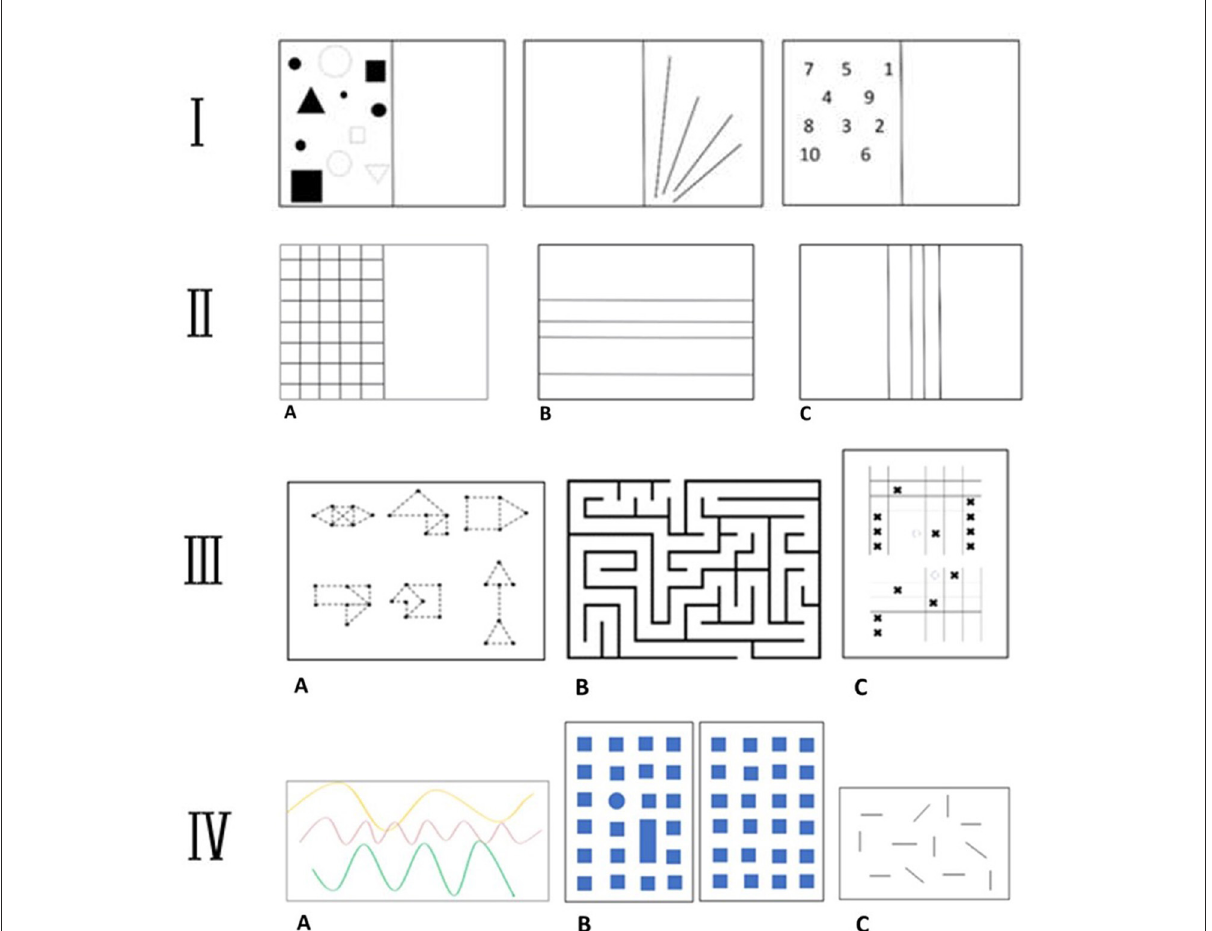
FIGURE1 Rehabilitation protocol. (I) Cognitive exercise. The physiotherapist gives the patient time to study the image’s shapes/lines/numbers (position, size, etc.), before covering up the completed half of the page and asking him/her to draw one or more elements in the same position (short-term memory). (II) Cognitive exercise. (A) The physiotherapist gives the patient a few minutes to study the image; then, with his/her eyes closed, the patient has to put his/her finger in a requested position (upper limb proprioception). (B, C) The patient has to study the distance between the lines. The physiotherapist will then ask him to draw new lines in specific positions (spatial perception). (III) Problem-solving test. (A) The patient has to join the dots, without going through any of them twice. (B) A labyrinth. (C) Patient plays against physiotherapist, seeking to the completion of the line with the same symbol. (IV) Cognitive exercise. (A) The physiotherapist shows the patient three paths painted on the floor. They walk along each of them together paying attention to bends and changes of direction. Then physiotherapist then guides the patient, with eyes closed, along one of the paths and he/she should recognize which it is (motor skills). (B) The physiotherapist shows the patient a path on the map. The patient then replicates that path (short-term memory and spatial orientation). (C) The Barrage Test (visuo-spatial